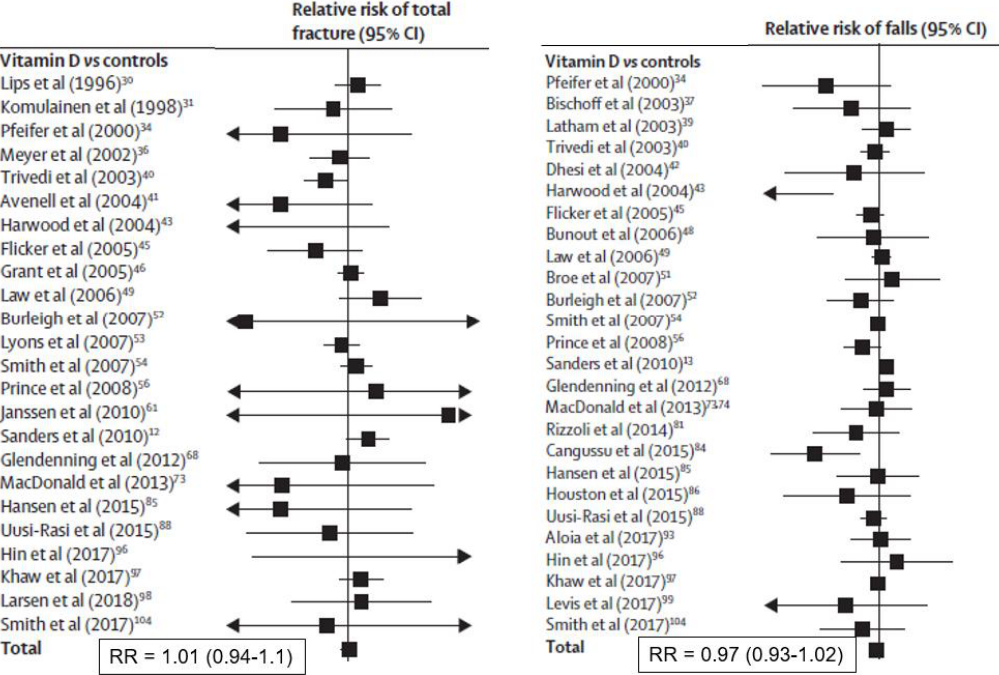
Figure 3. Random effects meta-analyses of effects of vitamin D monotherapy on total fractures (left panel) or falls (right panel) [23]. Eligible studies were randomized controlled trials of adults (>18 years) that compared vitamin D with untreated controls, placebo, or lower-dose vitamin D supplements. Trials with multiple interventions (e.g., co-administered calcium and vitamin D) were eligible if the study groups differed only by use of vitamin D. Studies of hydroxylated vitamin D analogues were excluded. From: Bolland et al., Effects of vitamin D supplementation on musculoskeletal health: a systematic review, meta-analysis, and trial sequential analysis. Lancet Diabetes Endocrinol 6: 847-858, 2018 [23]. Used with permission.